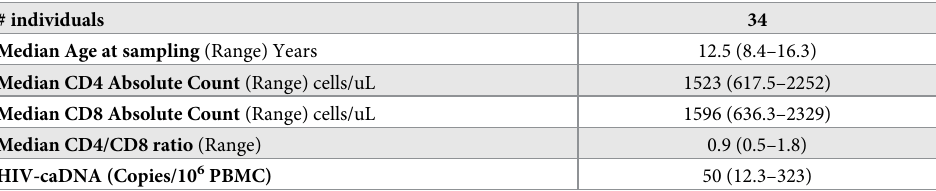
Table 1. Characteristics of study